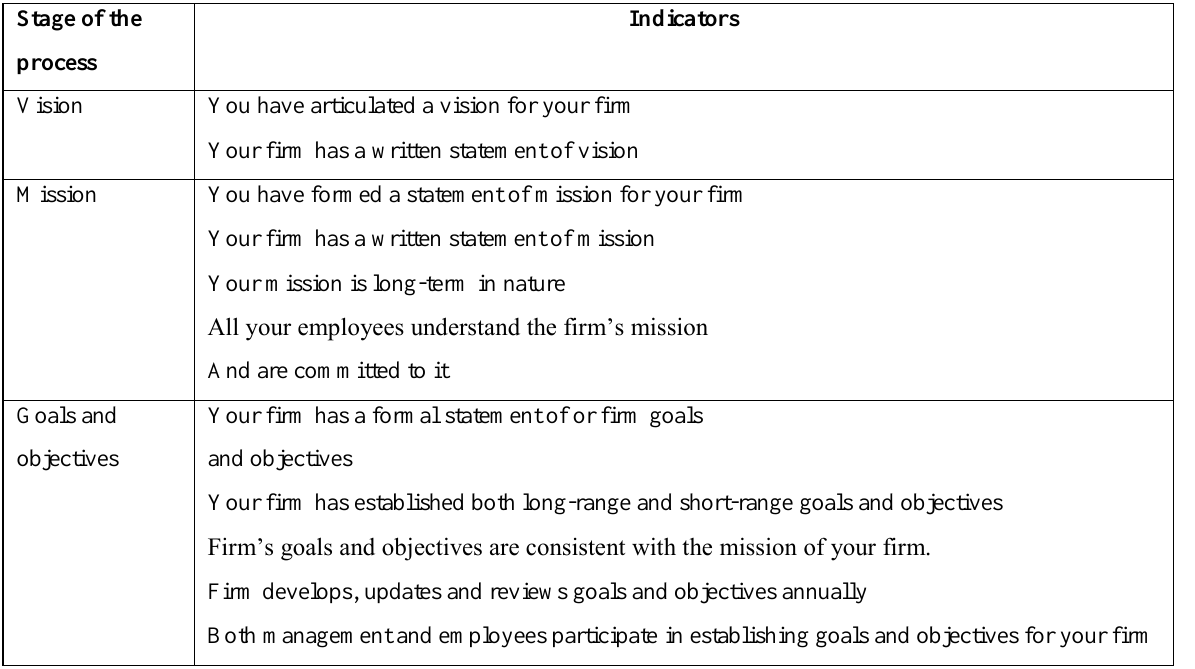
Table 3: Indicators of Strategic Planning